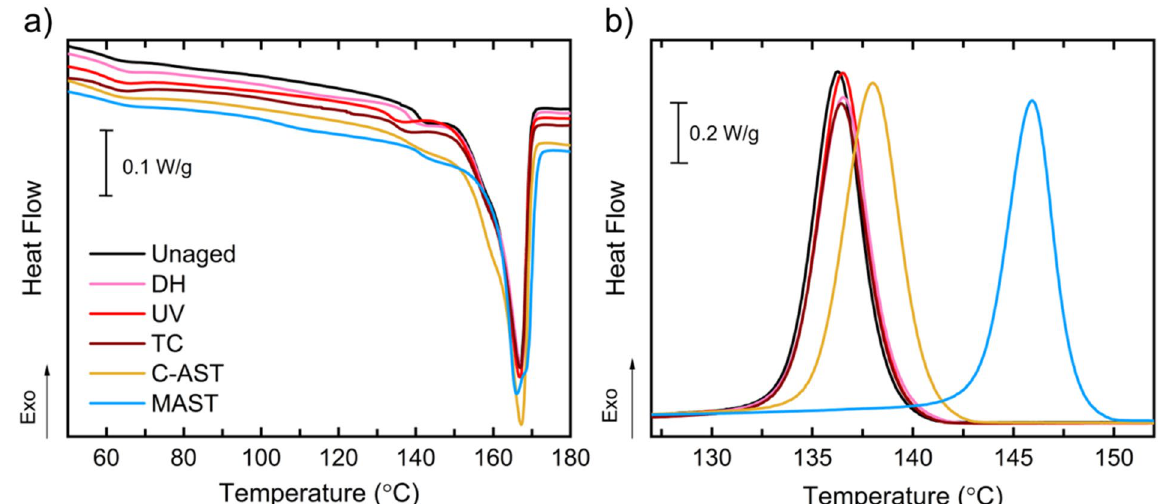
Figure 3. DSC thermograms of single-layer PVDF-A: ( a ) first heating cycle and ( b ) cooling cycle. The curves are offset vertically in ( a ) to better distinguish the experiments.